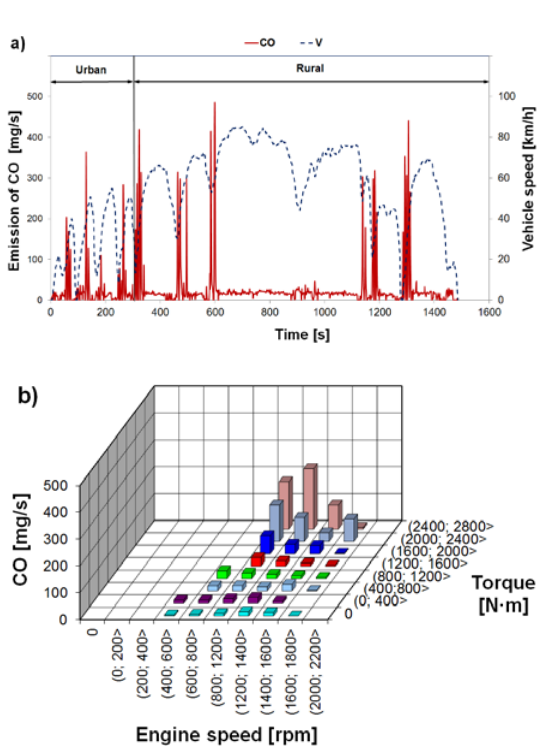
Fig. 6. The emission intensity of CO with vehicle speed (a) and emission intensity in engine speed and load intervals